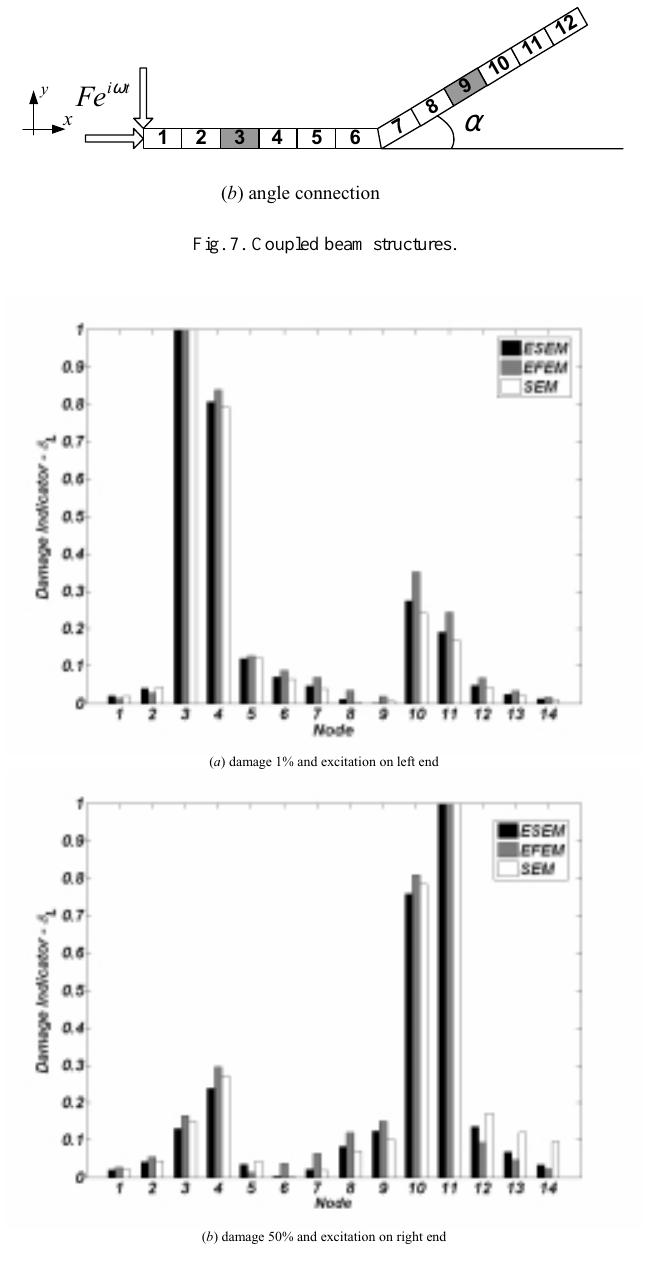
Fig. 8. Longitudinal damage indicator by ESEM, SEM and EFEM for beams cross section variation